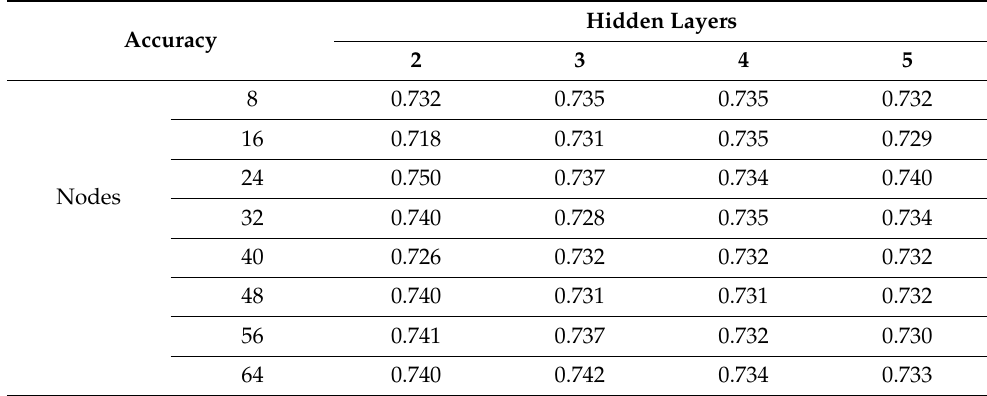
Table 7. Accuracy of the DNN by varying the number of hidden layers and the number of nodes in each hidden